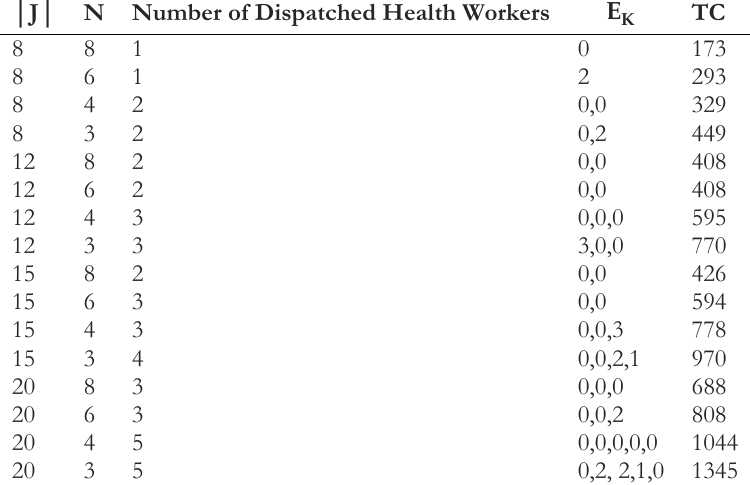
Table 6. Sensitivity analysis on the specified maximum number of visits for each health